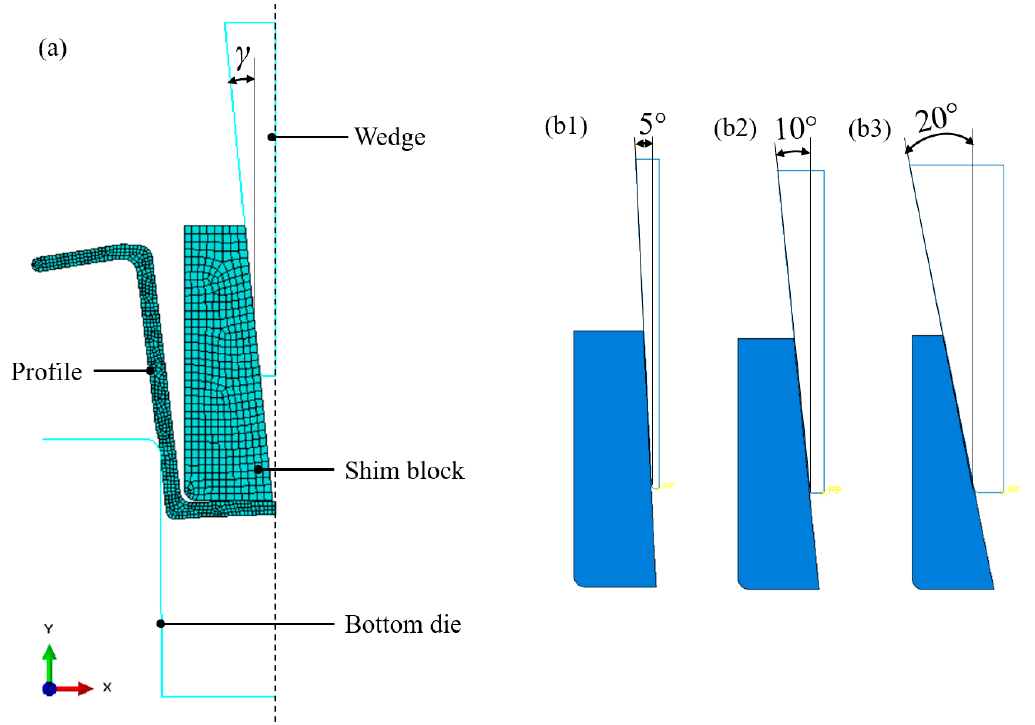
Figure 4. Description of ( a ) the finite element model for the TSLB process with ( b1 – b3 ) three different tool